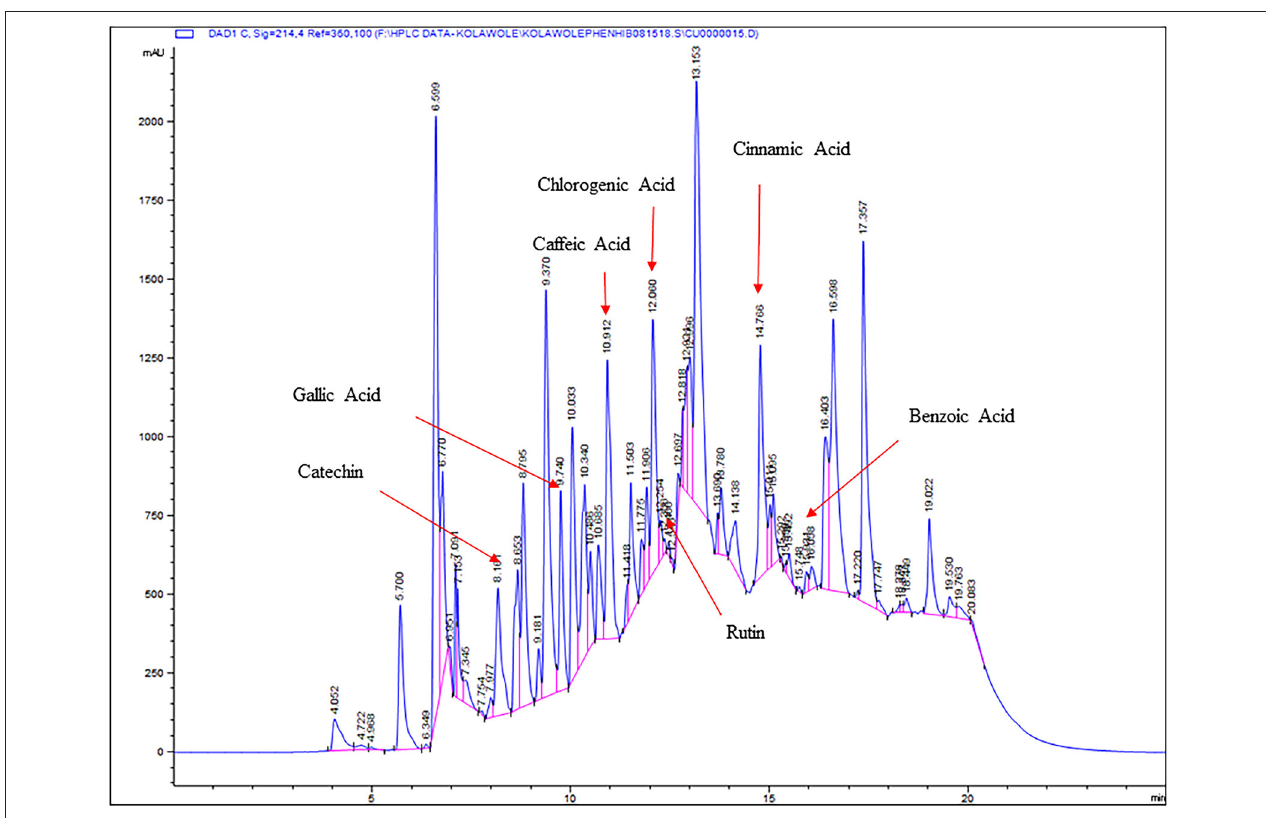
TABLE 2 | Major phenolic compounds ( µ g/g DW) in four different organic solvent extracted fractions of calyces of Hibiscus sabdariffa (Roselle). Hibiscus Fractions